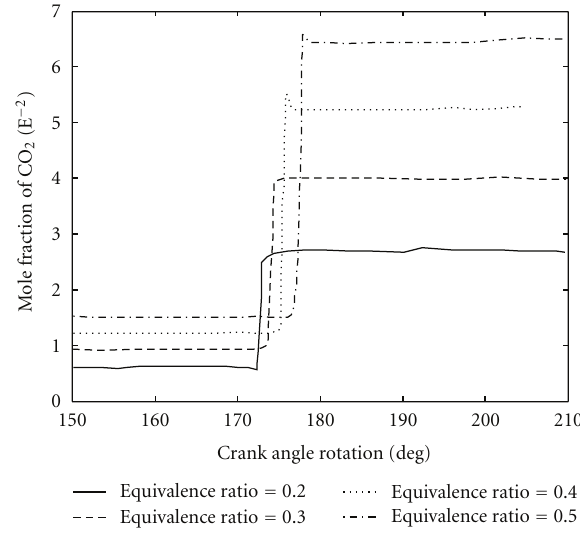
Figure 11: E ff ect of temperature variations on in-cylinder temper- ature.